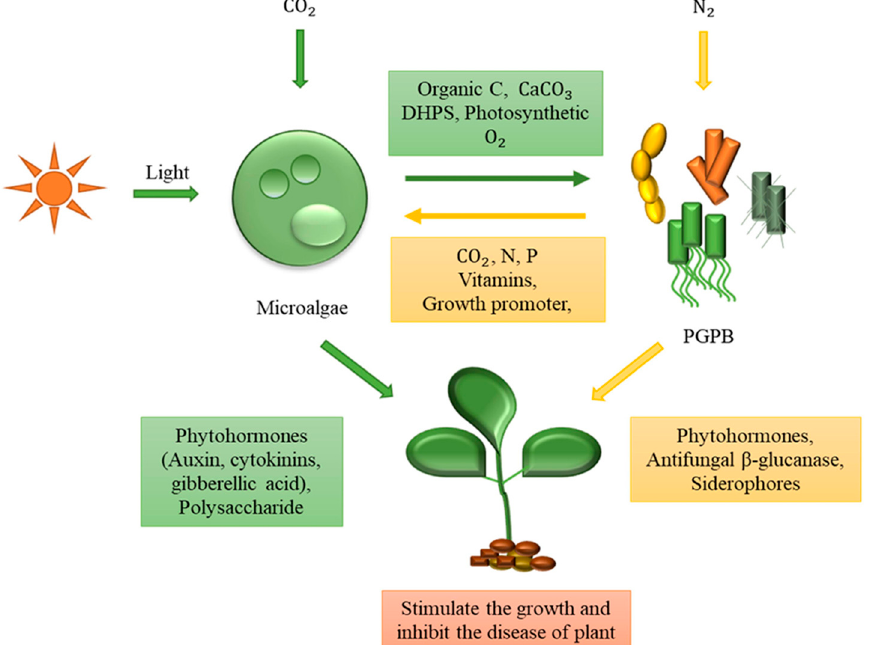
Figure 5. Consortia microalgae based can stimulate the plant growth-promoting bacteria (PGPB) allowing a sustainable agriculture. In detail, the microalgae cells and PGPB establish a beneficial exchange of nutrient molecules, and together enhance plant growth by producing phytohormones and other growth stimulants. Furthermore, this consortium can prevent the occurrence of certain plant diseases with particular suppressive mechanisms. Reprinted with permission from Kang et al. (2021). Potential of Algae–Bacteria Synergistic Effects on Vegetable Production. Frontiers in Plant Science [102]. Copyright (2021) Frontiers.